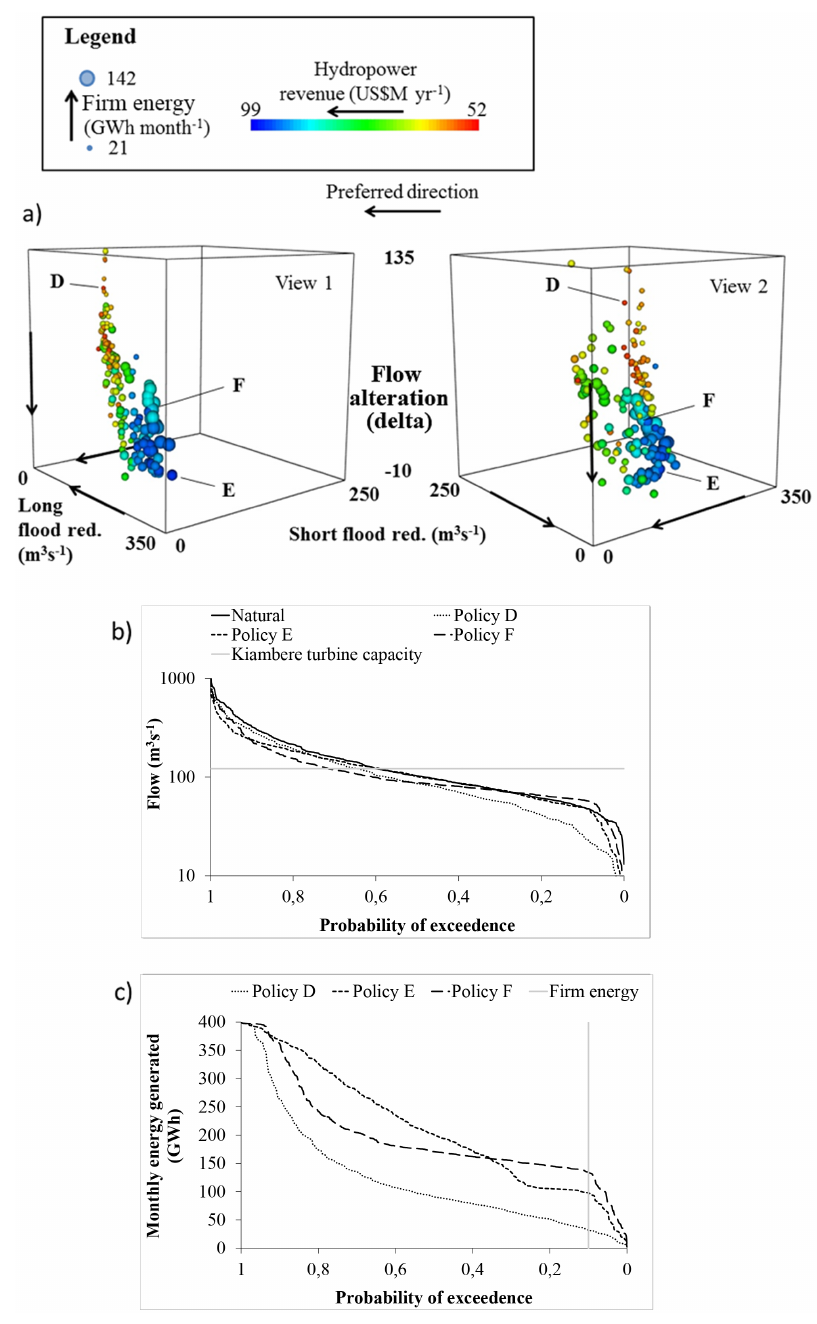
Figure 4. (a) The same trade-off surface as Fig. 3a with firm energy added using sphere size and hydropower revenue shown with colour. Larger spheres indicate higher firm energy; blue spheres mean high revenues. Three policies (D, E, F) illustrate trends across the surface. Moving from D to E, hydropower revenue increases as flood peaks are reduced but flow regime alteration becomes less pronounced. From E to F long flood peaks are increased as a result of higher storage levels, increasing uncontrolled releases, and flow regime alteration is increased to conserve water for firm energy generation. (b) Comparison of the natural flow duration curve with those resulting from the three selected policies of (a) . Lower flows are increased by sacrificing higher flows as we move across the trade-off surface in (a) from Policy D to E. This results in 79% higher hydropower revenue. The Policy E curve departs from the natural curve at the turbine flow (i.e. productive) capacity of the Kiambere plant. Policy F brings around 10% more flows within the productive capacity at Kiambere than Policy E and increases low flows above the natural regime. (c) Energy generation implications of the three policies labelled in (a) . Firm energy is the level of generation which can be provided with 90% reliability. Policy F best sustains energy generation to achieve firm energy 326% higher than Policy D and 37% higher than Policy